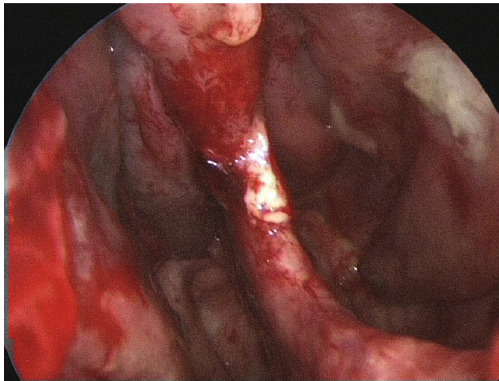
Figure 4: Endoscopy of the right nasal cavity following removal of the nasal dressing 2 weeks after the last radiotherapy showed a vast septal perforation due to multiple endonasal interventions. A 3mm bluish spot at the dorso apical border of the septal perforation and very fine teleangiectatic vessels were the only possible and now inactive sites of the former extensive teleangiectatic